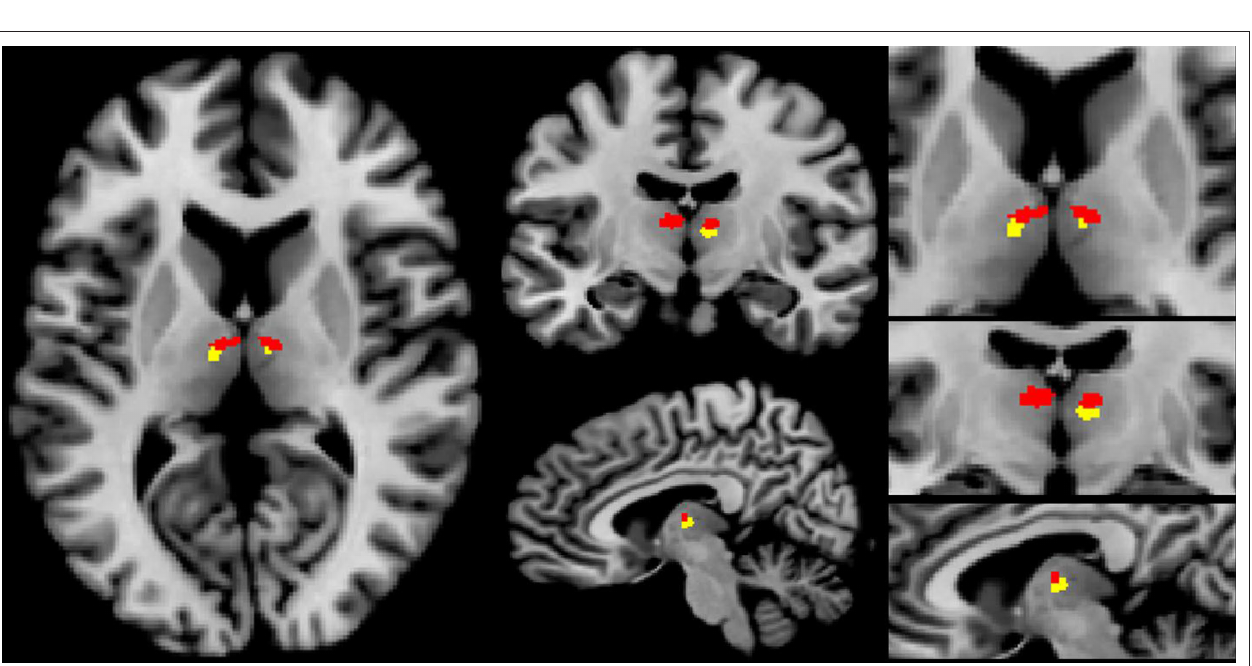
FIguRe 5 | Bilateral activation in the ventral anterior thalamic nucleus was revealed by the contrast [anticipation of erotic pictures > anticipation of emotional pictures] at an uncorrected threshold of p < 0.001, x : 4; y : − 6; z : 5.